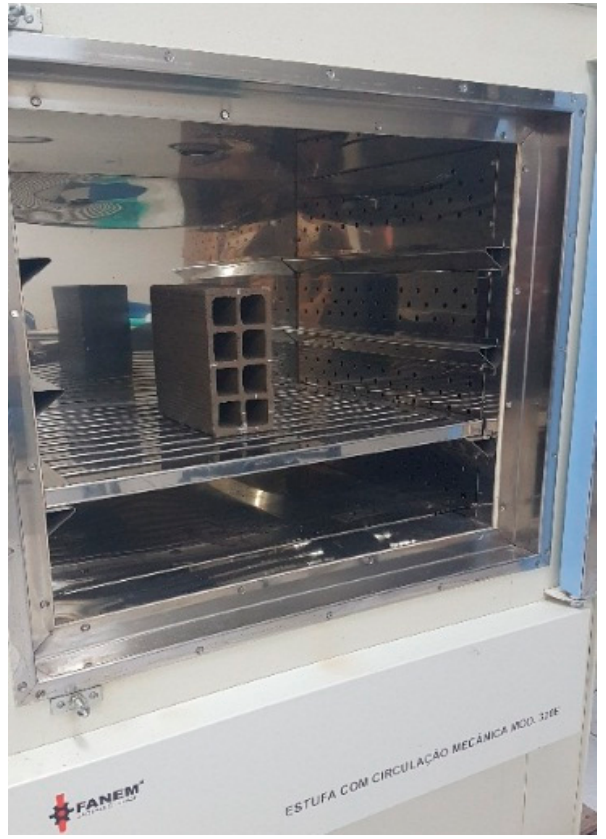
Figure 1. View of the ceramic brick in the drying oven (model 320E, FANEM, São Paulo, Brazil).